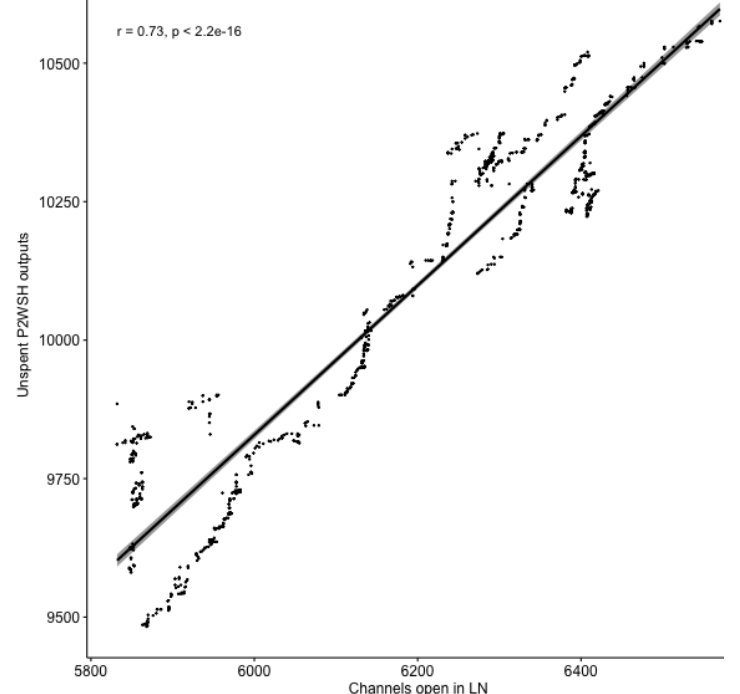
Figure 13. Correlation between unspent P2WSH outputs and channels open in the LN